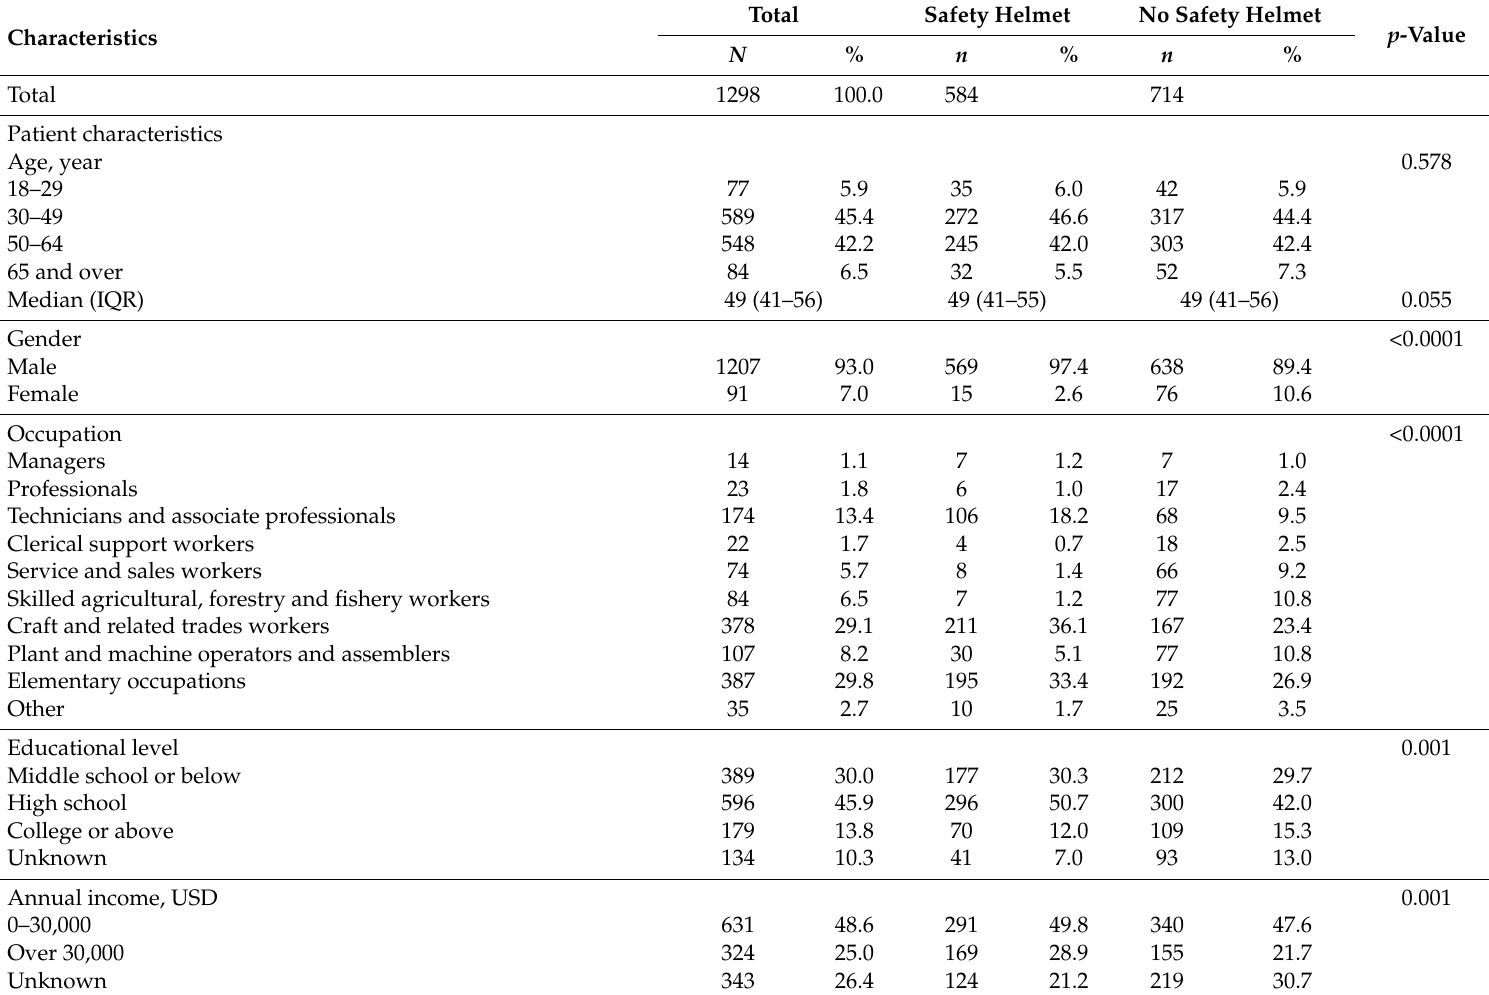
Table 1. Demographic findings of study population by safety helmet